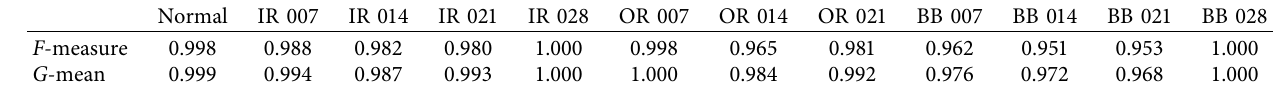
Table 13: PART +multiboost performance in terms of F -measure and G -mean values for Exp. 4.